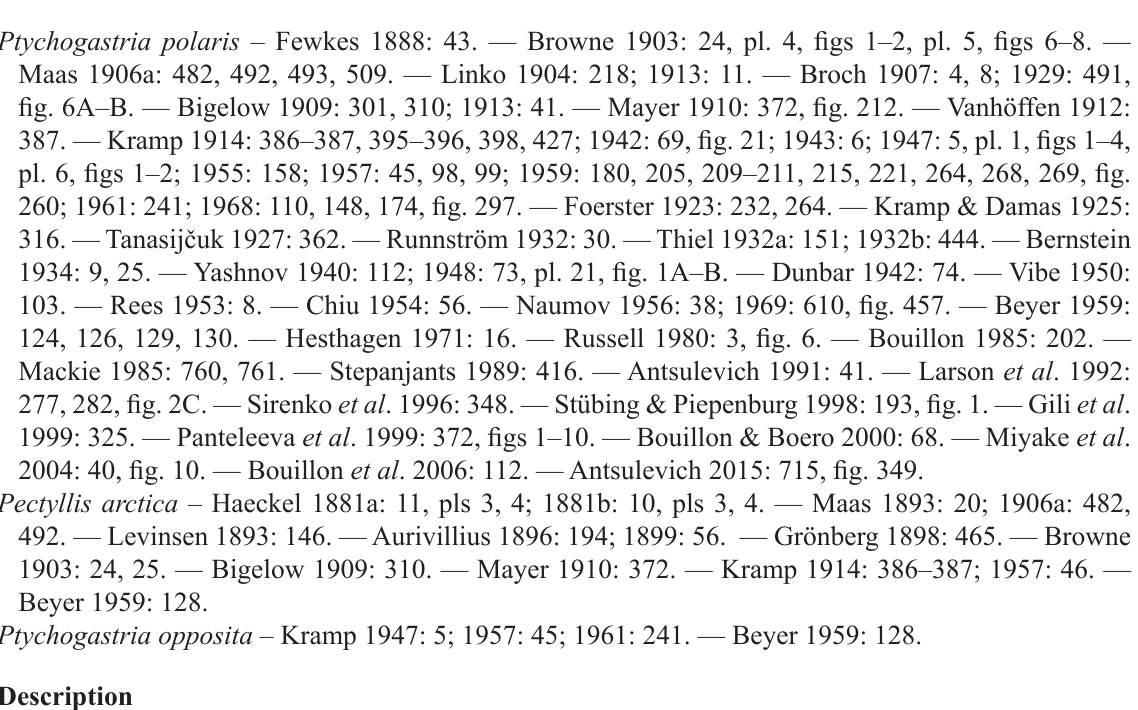
fig. 6A–B. — Bigelow 1909: 301, 310; 1913: 41. — Mayer 1910: 372, fig. 212. — Vanhöffen